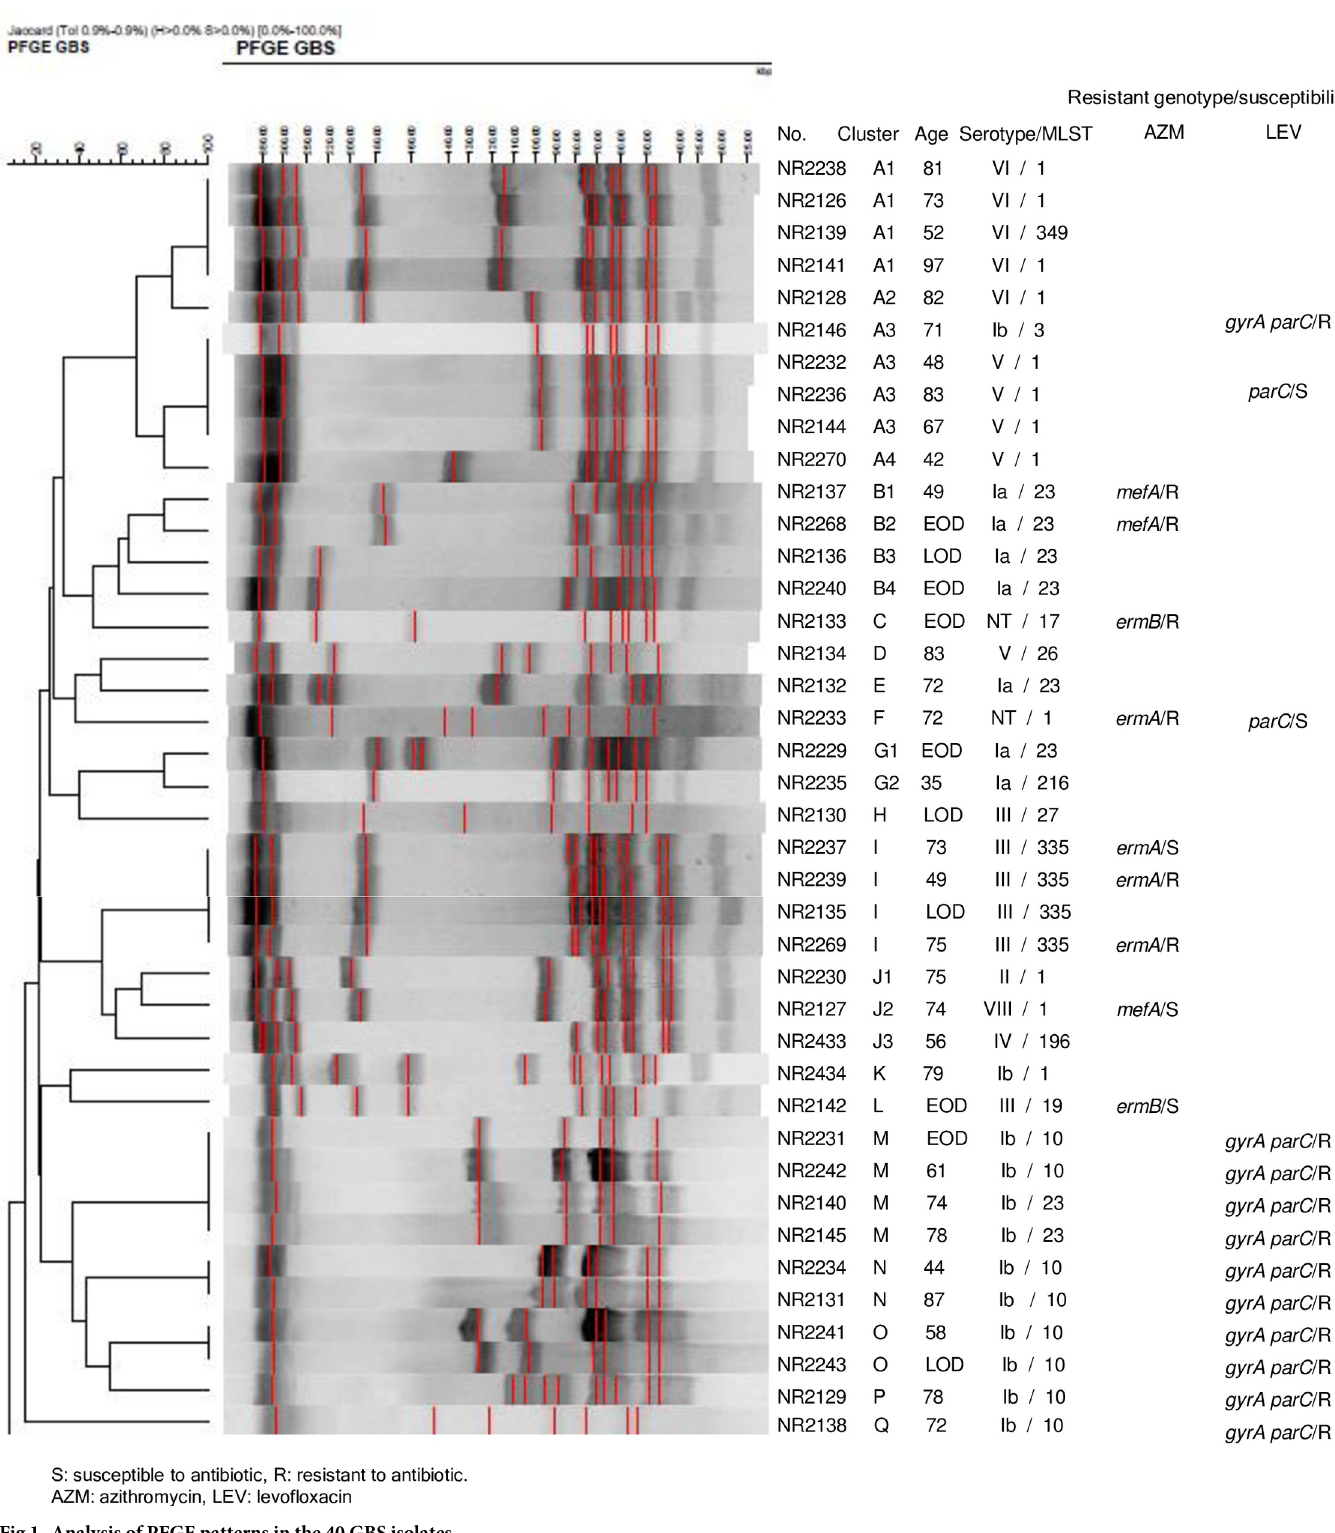
PLOS ONE | https://doi.org/10.1371/journal.pone.0240590 October 19,